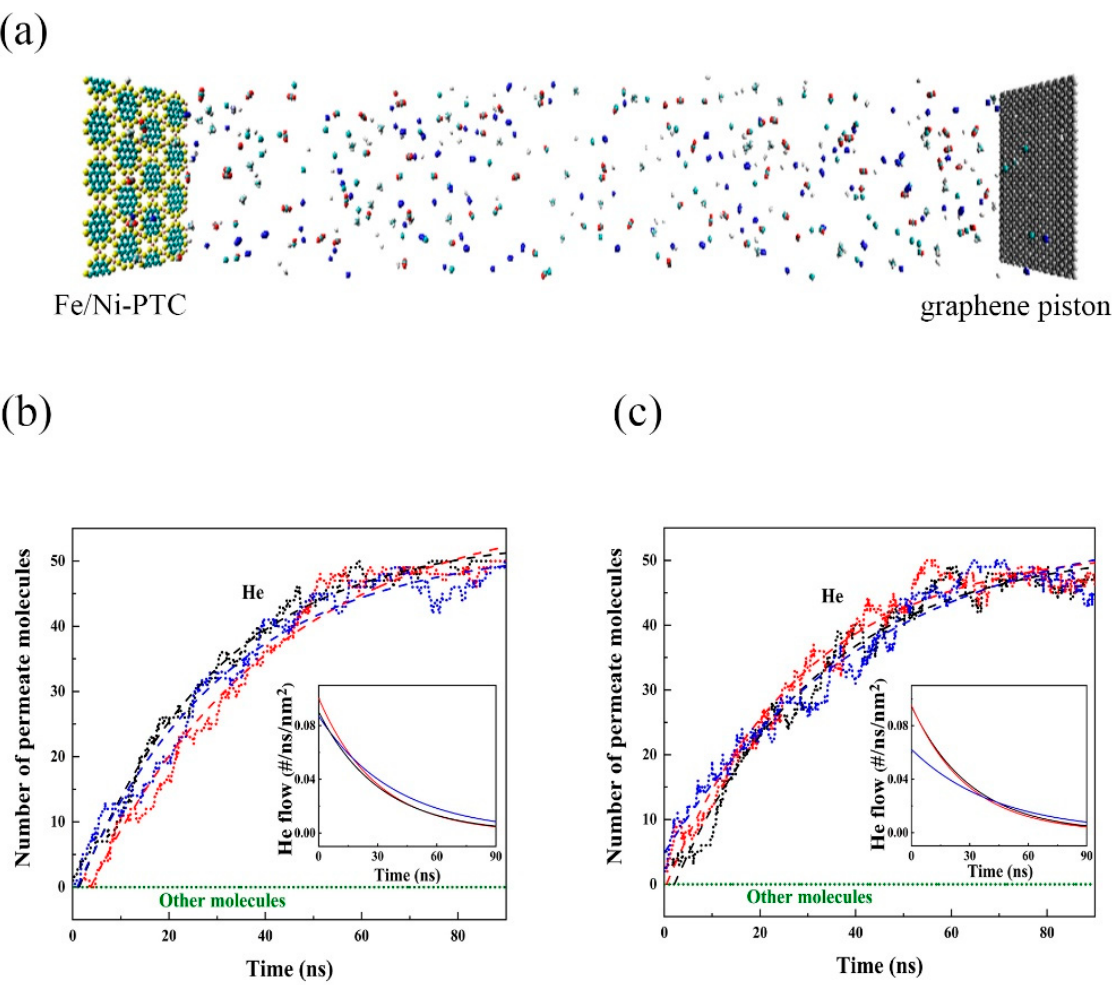
Figure 4. ( a ) The snapshot of the simulation model; pure He permeation by ( b ) Fe-PTC and ( c ) Ni-PTC membranes at 300 K, where individual results obtained from three independent trajectories are represented by red, blue, and black dots. The dashed lines are the numerical fitted results. The insets show the gas flow rates calculated from the numerical fitted results.